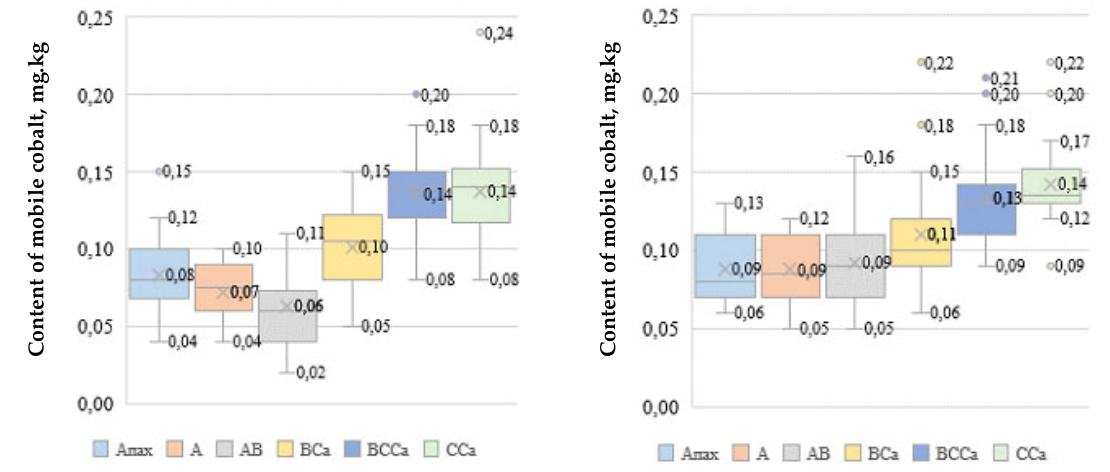
Figure 3. Contents of mobile forms of trace elements in the profiles of typical and ordinary arable chernozems. According to the results of the regional agroecological monitoring, it was found that during the period 1990–2009 there was a decrease in the weighted average contents of mobile compounds of manganese and zinc in arable soils. Since 2010, there has been a trend of increasing manganese content in soils, which is associated with an increase in the volume of organic fertilizers used in the region. The weighted average contents of mobile zinc and cobalt in soils from 2005–2018 did not change significantly (Figure 4).